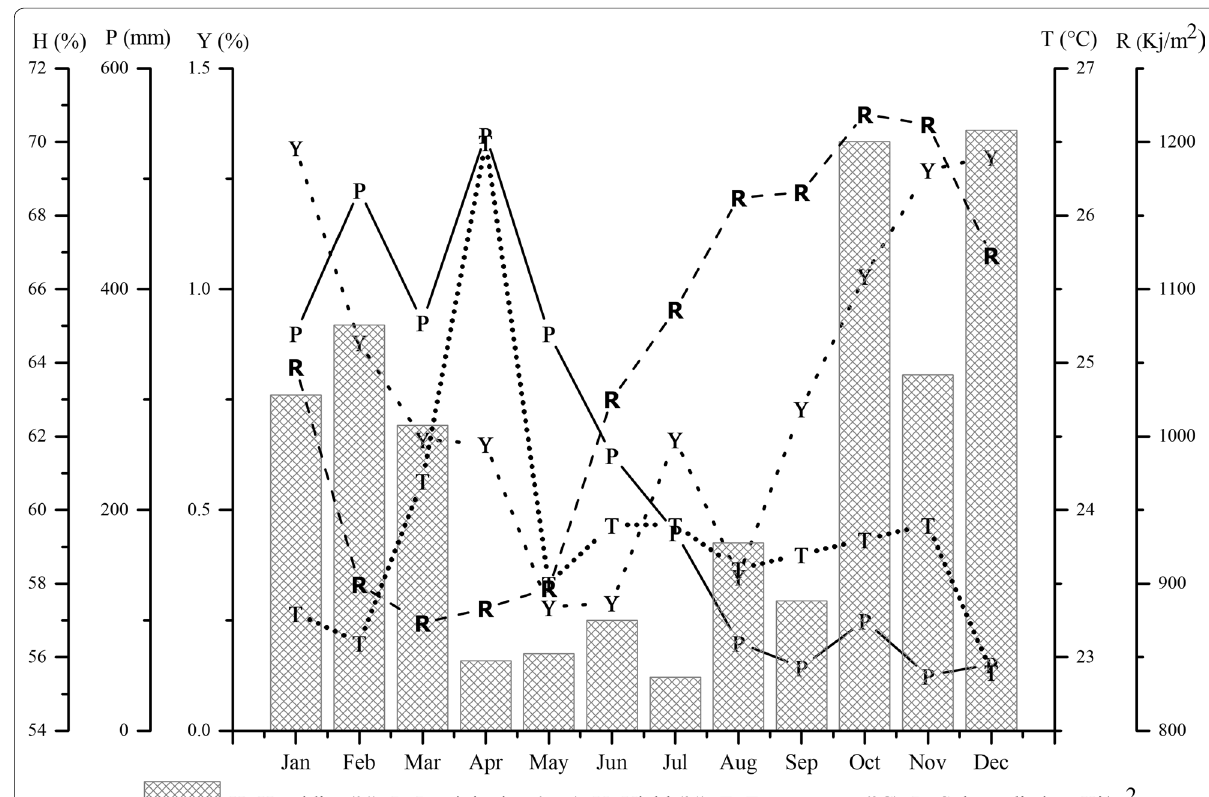
Fig. 1 Essential oils yield (%) of L. thymoides and climatic variables measured at the time of collection: relative humidity (%); precipitation (mm); temperature (°C) and solar radiation (Kj/m 2 )